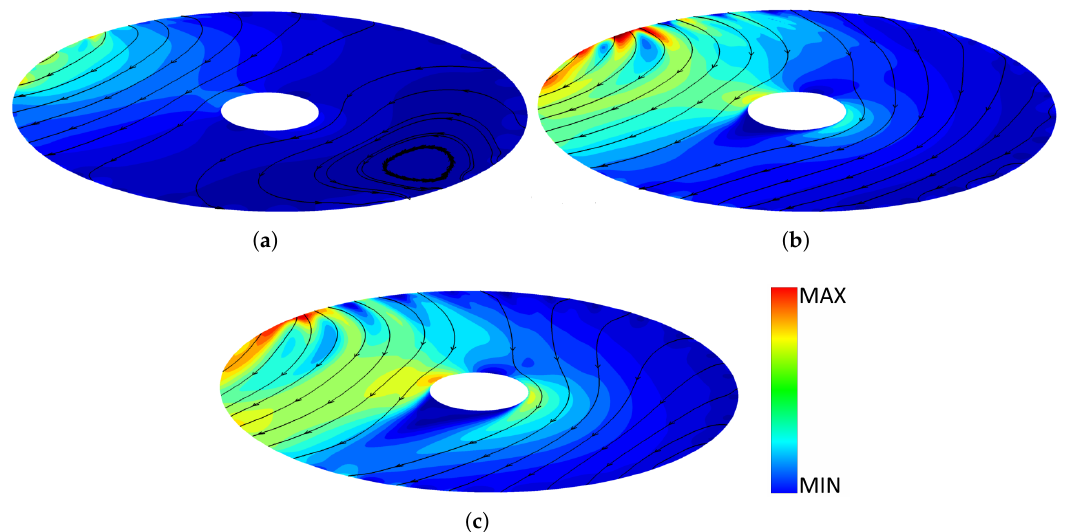
Figure 3. Contour of velocity on plane xy for various axial gap: ( a ) h/H = 0.00886; ( b ) h/H = 0.0177; and ( c ) h/H =